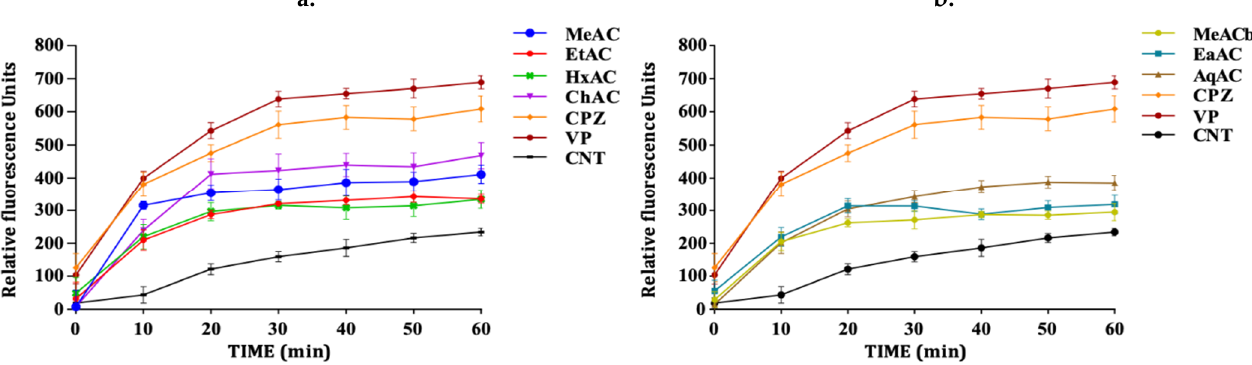
Figure 3. Effect of A. cepa on the accumulation of EtBr in P. aeruginosa. ( a ) A. cepa pink: MeAC-methanol, EtAC-ethanol, HxAC-hexane and ChAC-chloroform; ( b ) Allium cepa white: MeACb-methanol, EaAC-ethanol, AqAC-aqueous, CPZ— chlorpromazine; VP-verapamil; CNT-control.